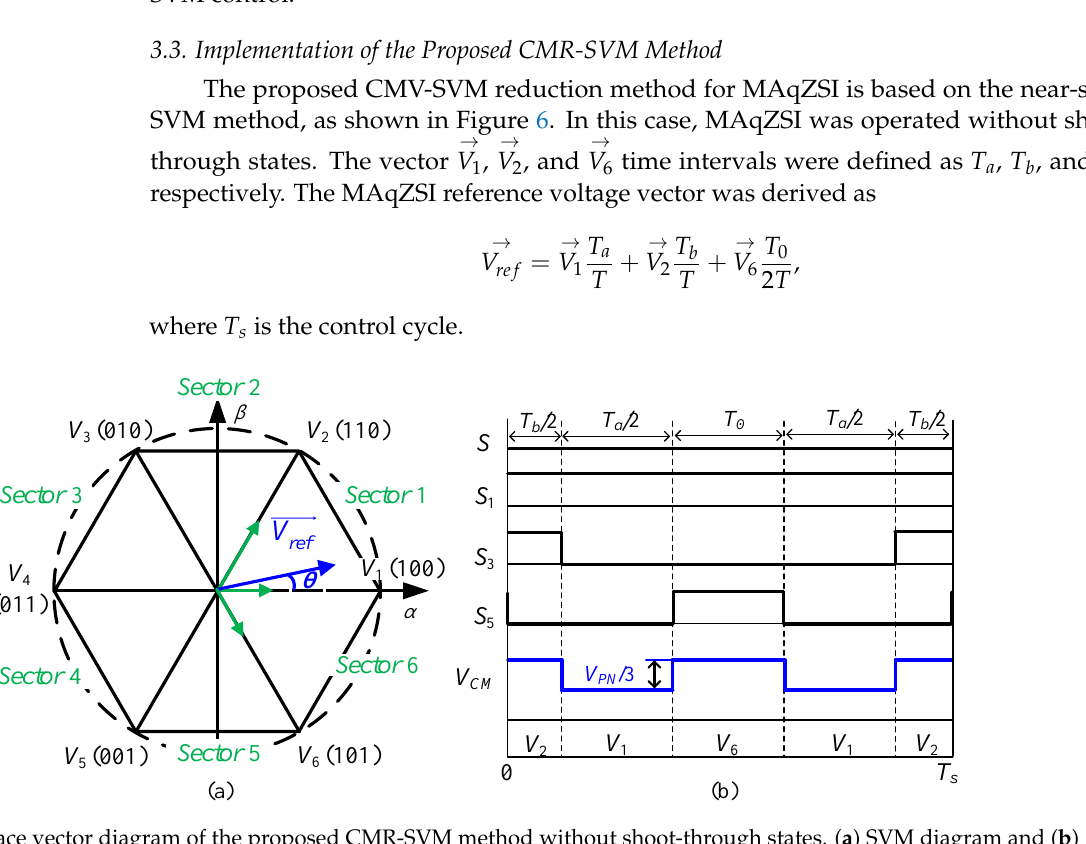
Figure 6. Space vector diagram of the proposed CMR-SVM method without shoot-through states. ( a ) SVM diagram and ( b ) switching states in Sector 1.